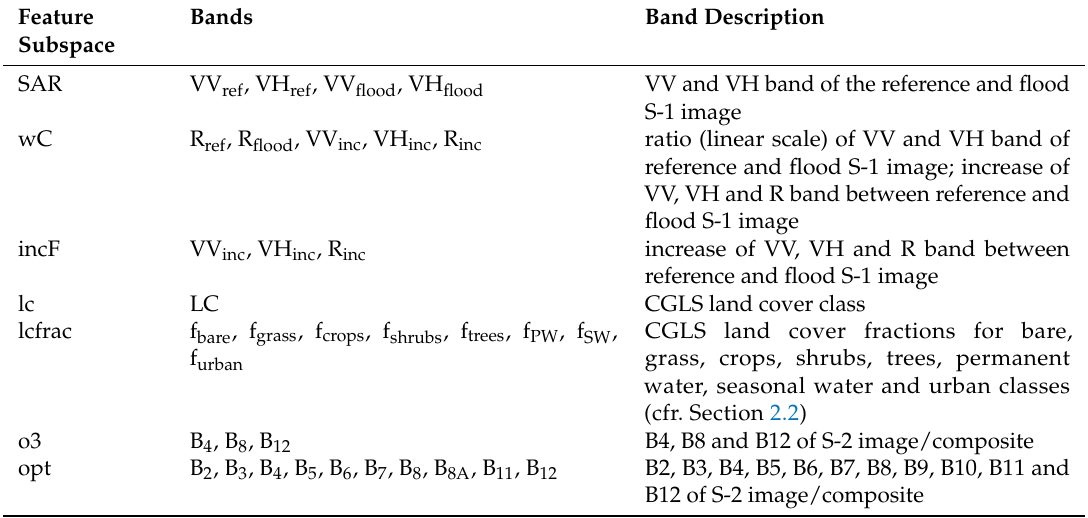
Table 2. Overview of feature subspaces considered for object